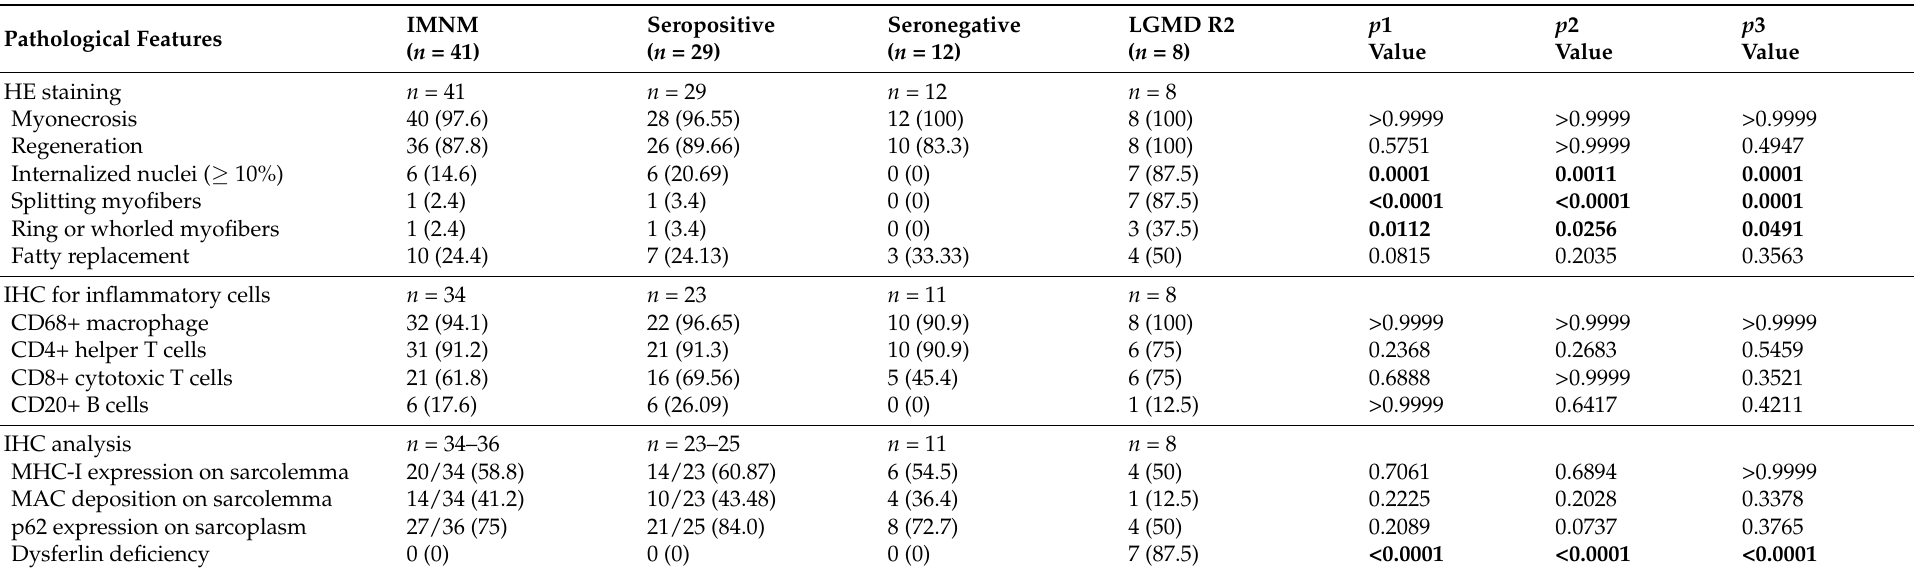
Table 2. Comparison of the histopathological features between IMNM and LGMD